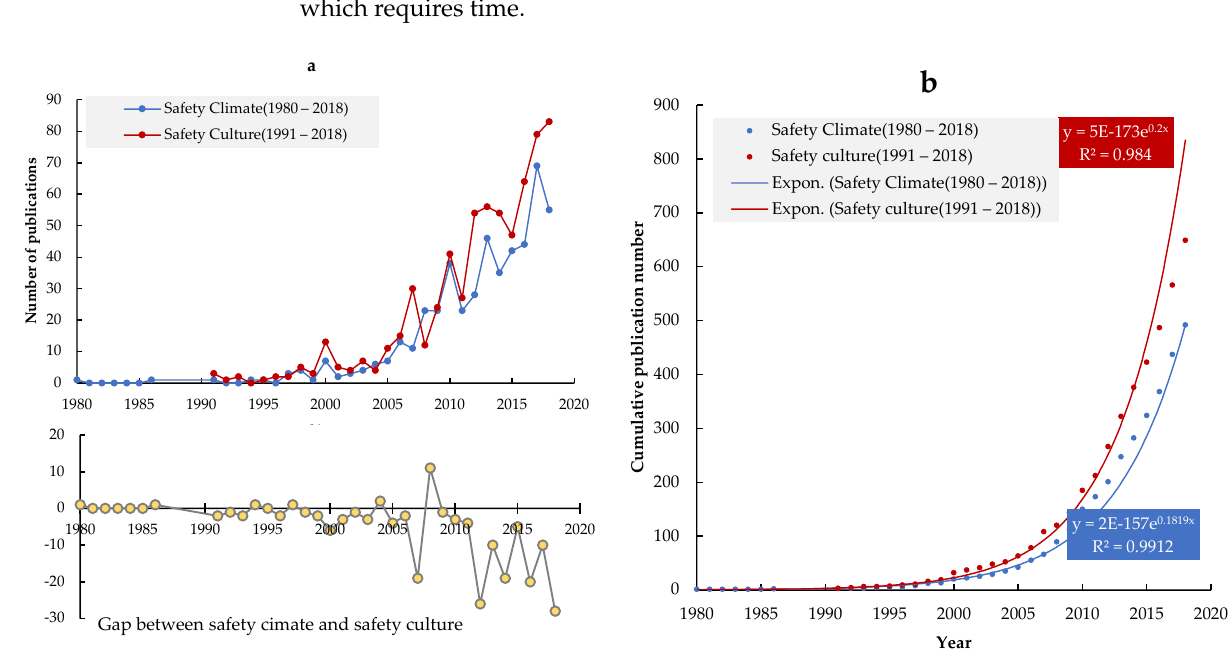
Figure 3. Trends in publication output of papers on safety climate and safety culture from 1980 to 2018. ( a ) Annual trends of the safety climate and safety culture publications, ( b )